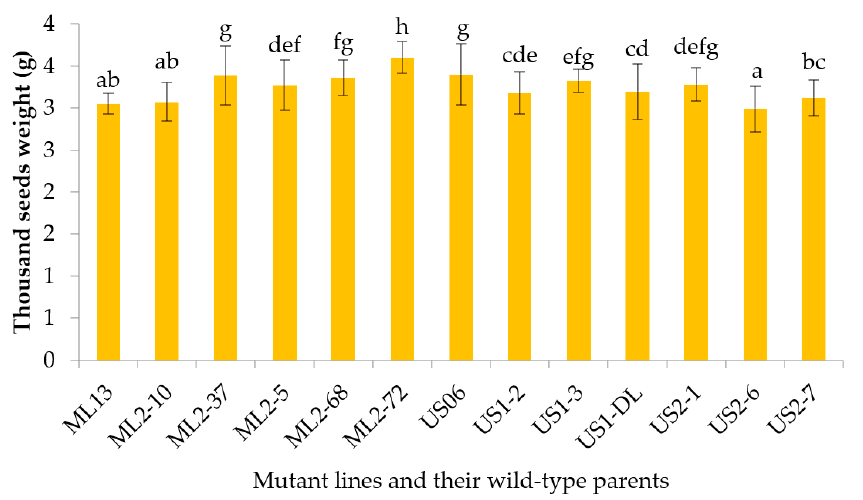
Figure 9. Thousand seeds weight (TSW) in 11 sesame mutant lines and their two wildtypes (US06 and ML13). The superscript letters represent the groups according to Duncan’s test.